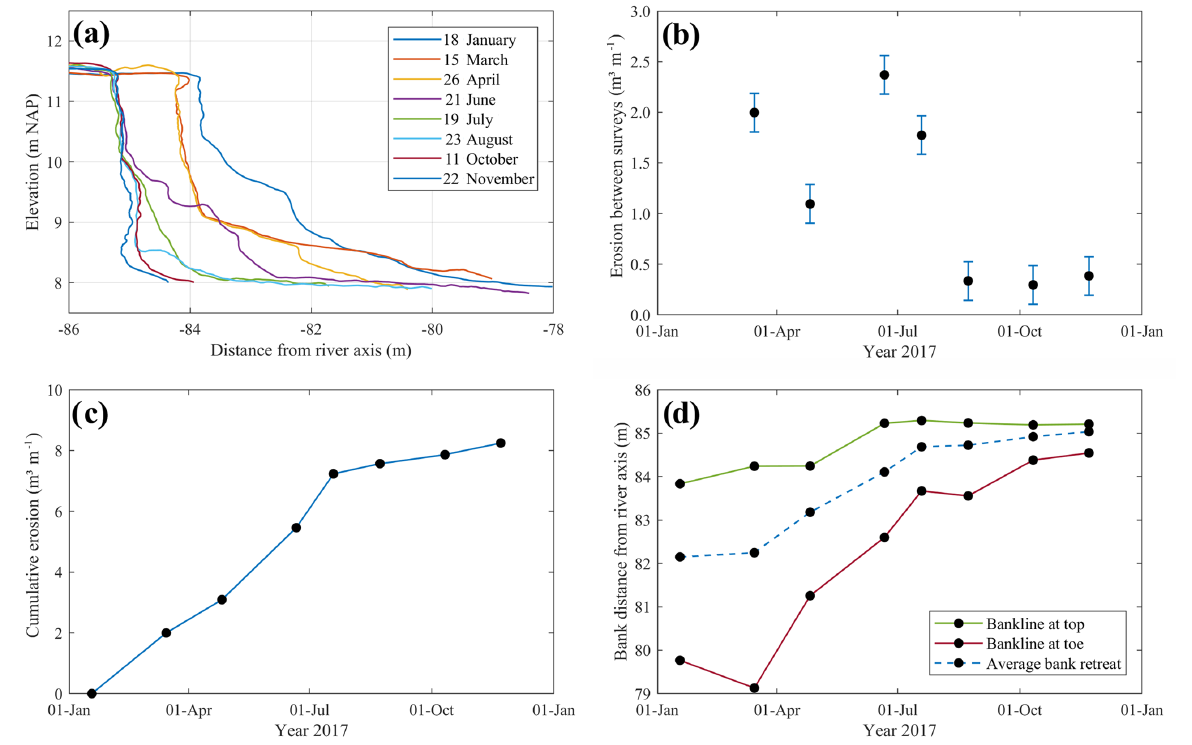
Figure 12. Sequential surveys at cross-section 4, Meuse River kilometre 153.9, over 2017. (a) Bank profiles from DSMs; (b) eroded volume per unit width between consecutive surveys; (c) cumulative erosion along surveys; (d) bankline locations at the top and toe of the